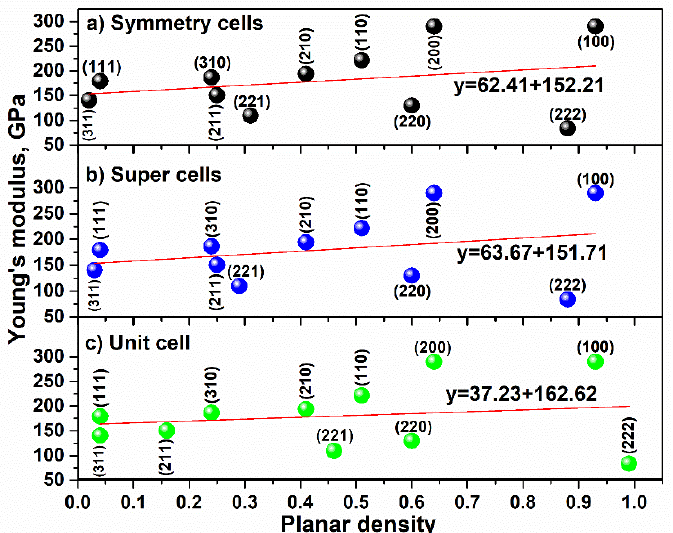
Figure 8. Young’s modulus versus planar density values of each diffracted plane related to the ( a ) symmetry cells, ( b ) super cells (2 × 2 × 2) and ( c ) unit cell of CaTiO ₃ .